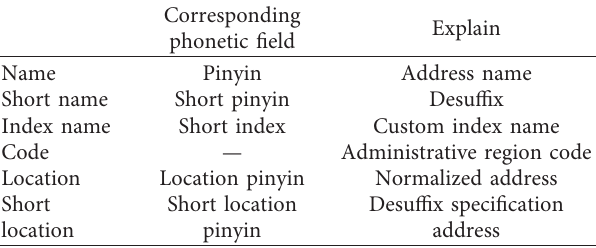
Table 1: Knowledge graph field information table.